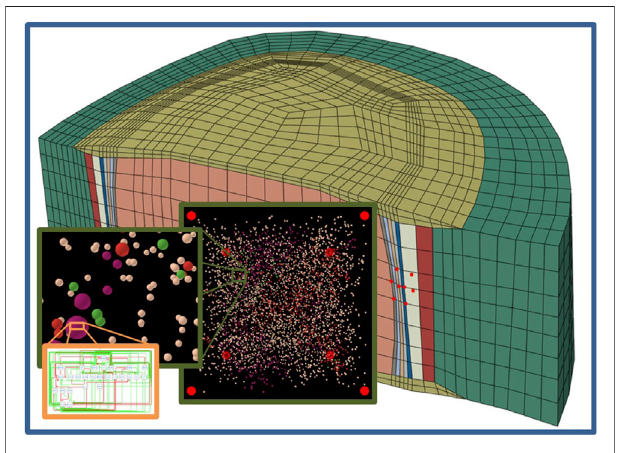
FIGURE 12 | Schematic integration of this modelling approach of the multicellularlevelintomultiscaleapproaches. Organ/tissuelevel (blueframe) , multicellular level (green frame) and subcellular level (orange frame)